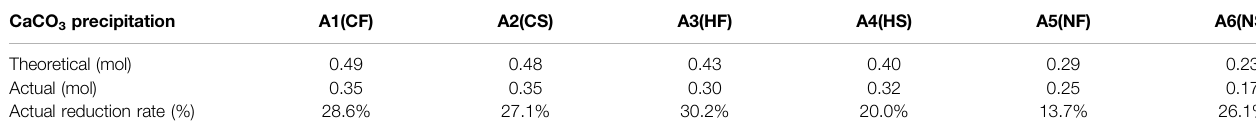
TABLE 2 | Relationships between theoretical mass value of calcium carbonate product and actual mass value of aqueous solution experiment. CaCO 3 precipitation